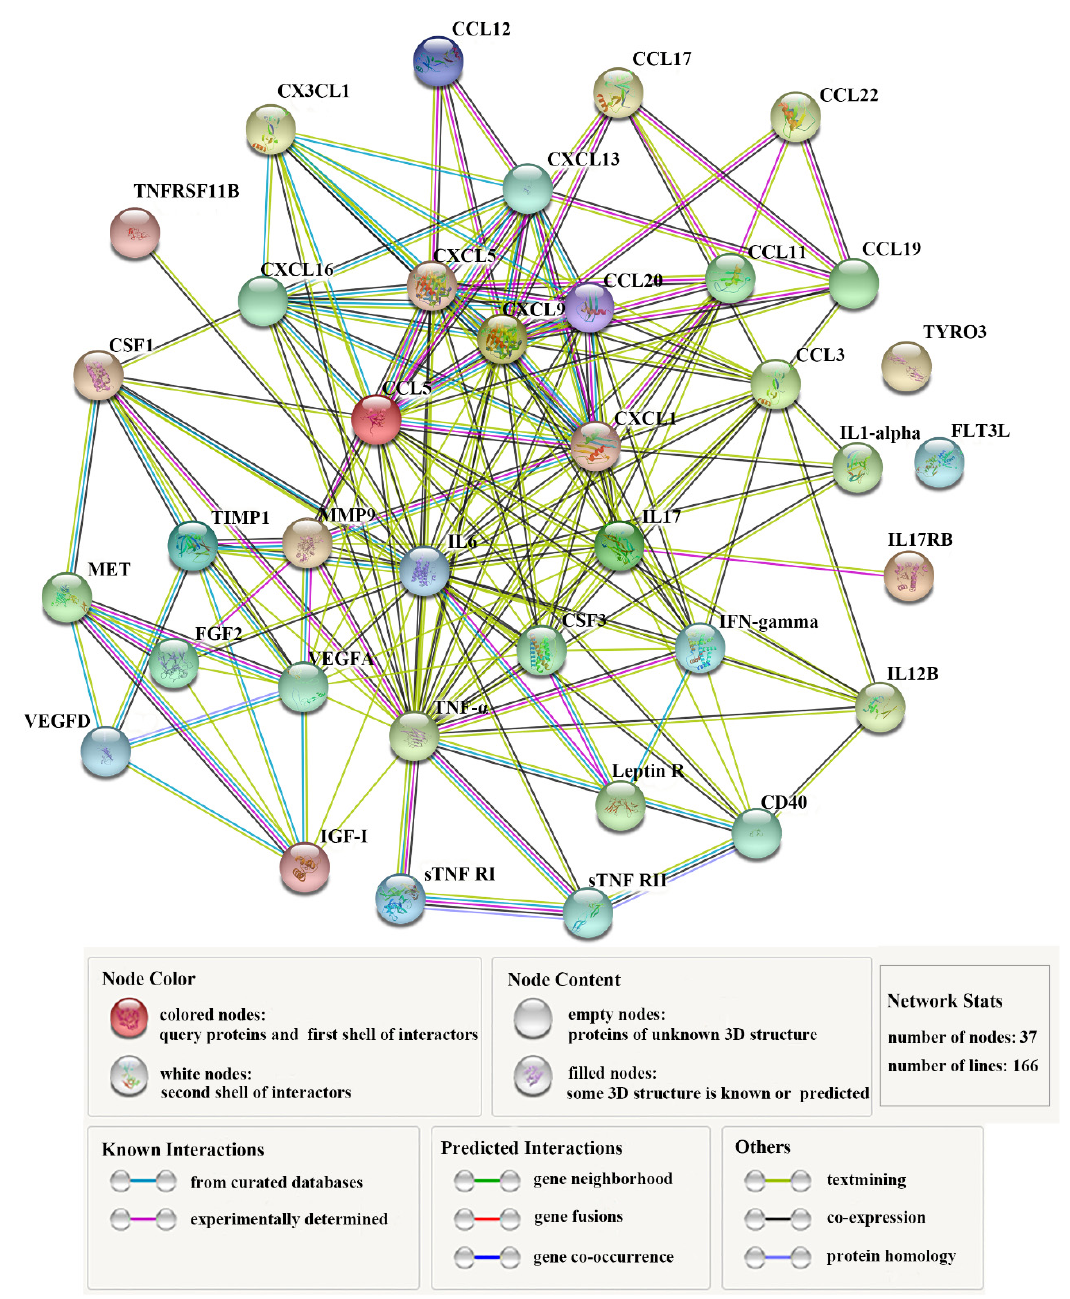
Figure 3. The interaction networks of differentially expressed cytokines (DECs). The networks formed by 37 DECs are shown. Nodes in the networks represent proteins; lines indicate association between the linked DECs.